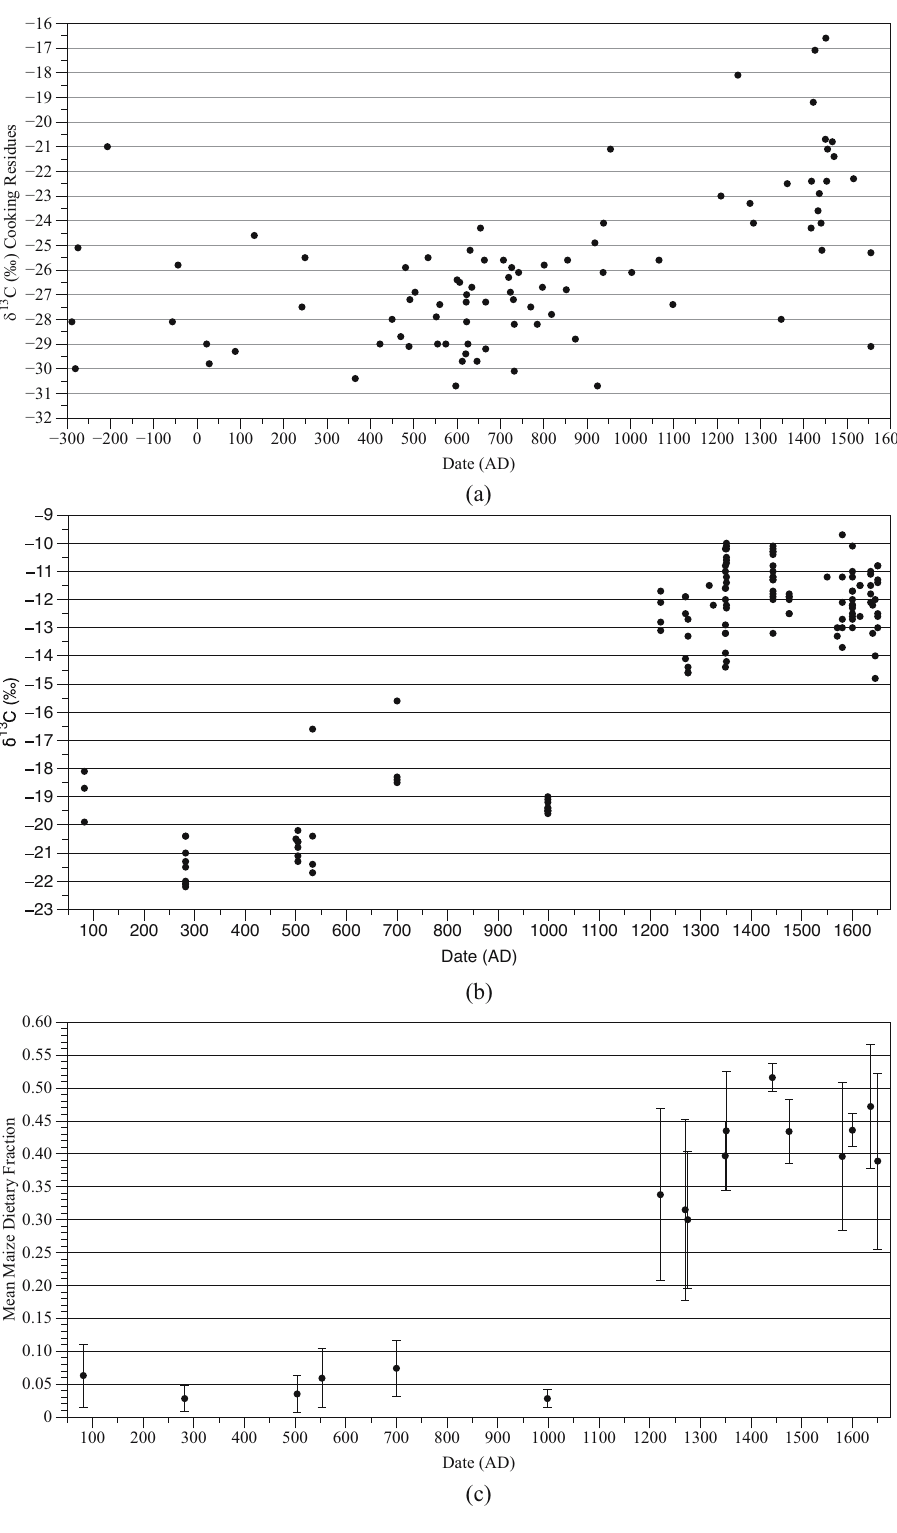
Figure 4: δ 13 C values by time for ( a ) charred cooking residues and ( b ) human bone collagen and ( c ) Bayesian dietary mixing model dietary fractions for maize ( error bars are 1 σ )